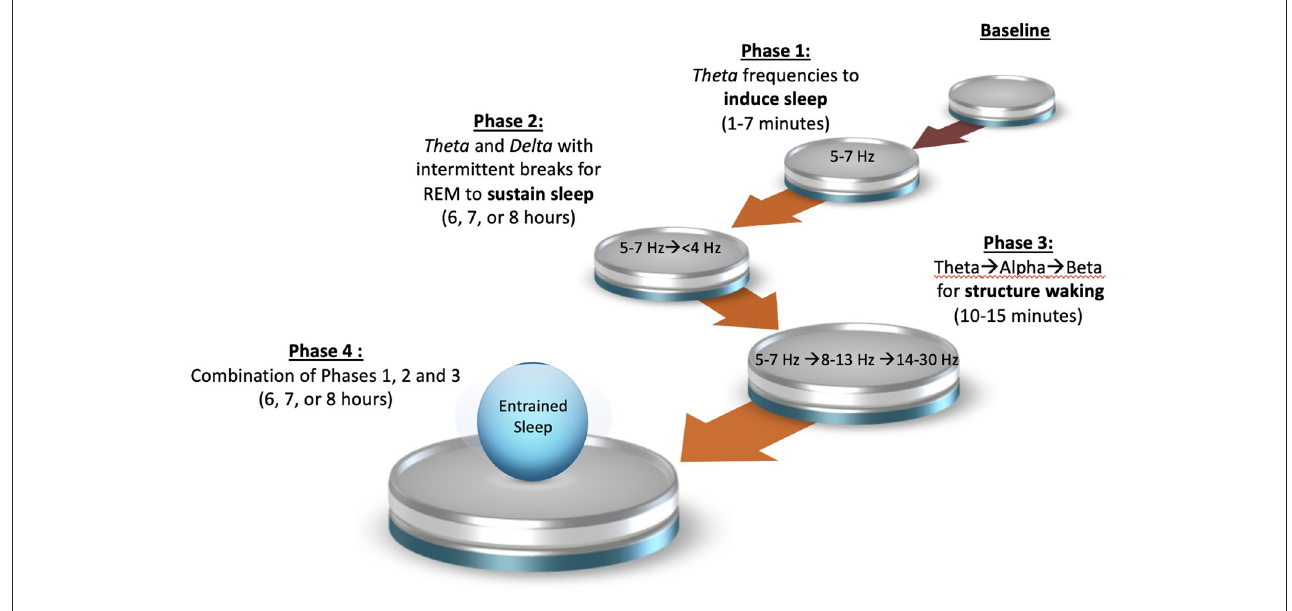
FIGURE3 Four phase binaural beat frequency study